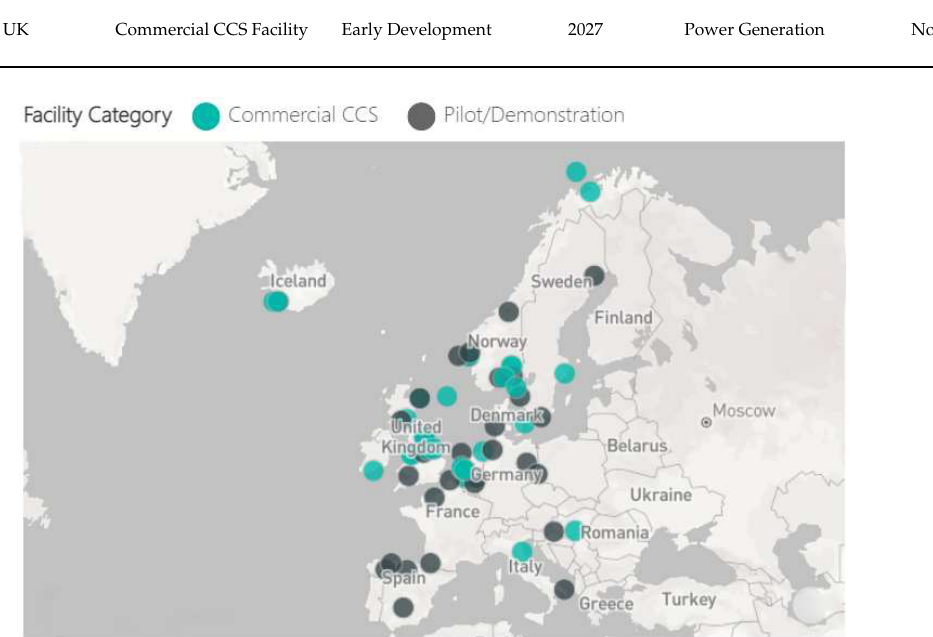
Figure 4. Representation of the Commercial-scale CCS Facilities around Europe. Map adapted from https://co2re.co/FacilityData.